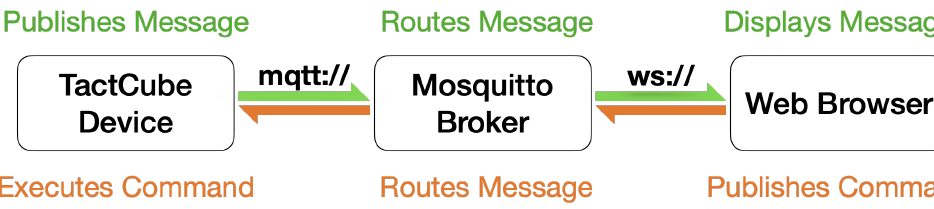
Figure 10. The two-way communications employed in the